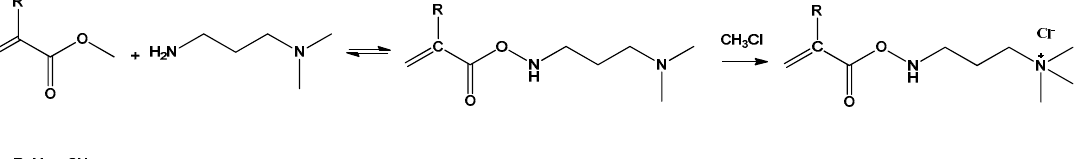
Figure 4. Synthesis routine of APTAC (or MAPTAC).